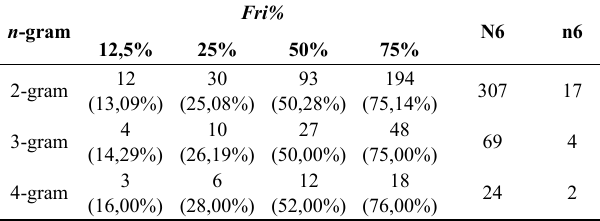
Table 2. N6 and n6 of the different n -grams from IHC.